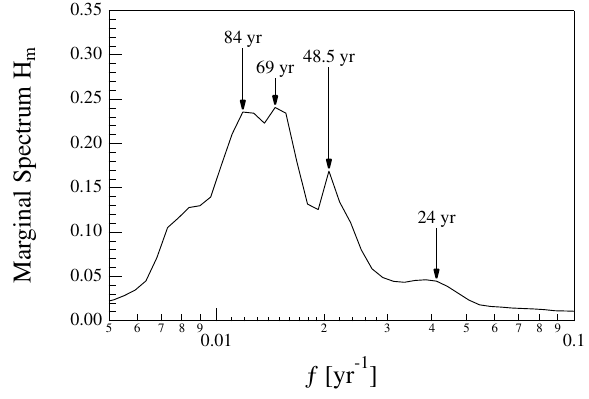
Fig. 7. Marginal spectrum H m (f ) computed using the ensemble averaged Hilbert spectrum h H ( f,t ) i shown in Figure 5.